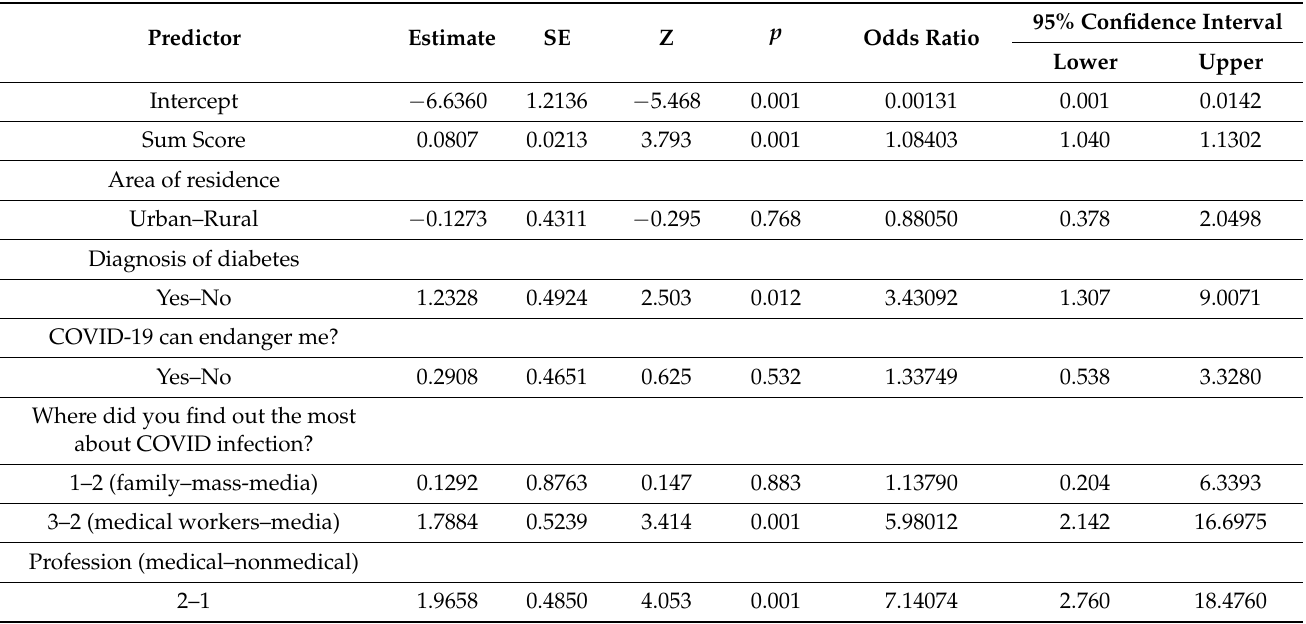
Table 8. Role of variables in predicting vaccination